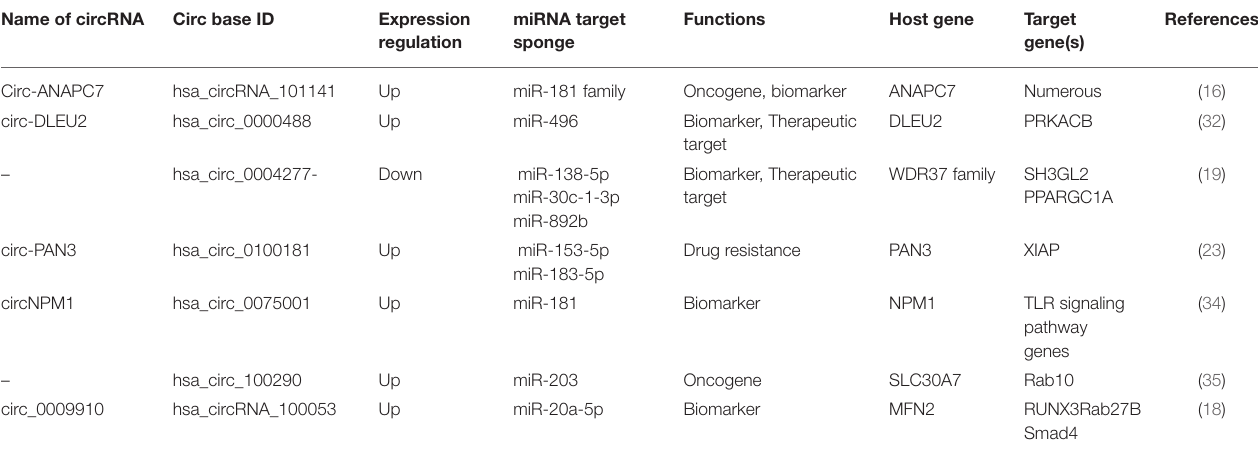
TABLE 1 | List of circular RNAs and their association with their respective miRNAs reported in AML. Name of